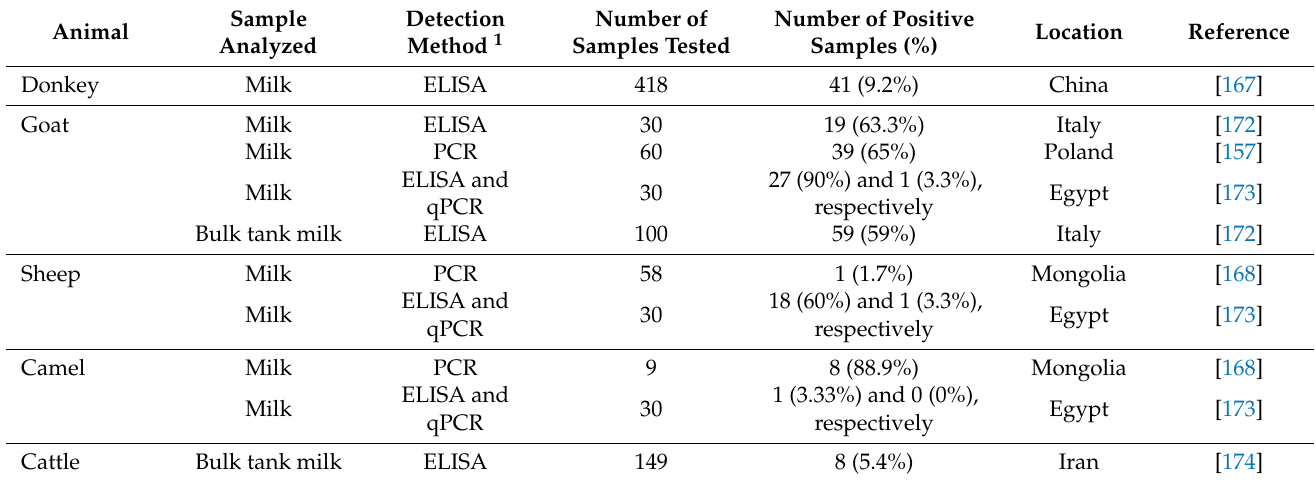
Table 3. T. gondii in milk and dairy products. The table shows the producer animal, sample con- taminated, country of contamination, method that was used for detection, and prevalence that was